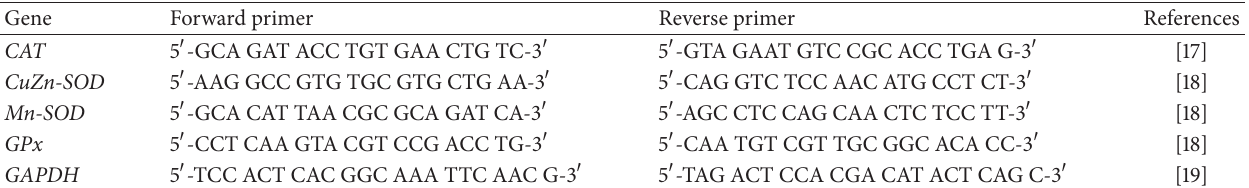
Table 1: Forward and reverse primers for mouse CAT, CuZn-SOD, Mn-SOD, GPx, and GAPDH.